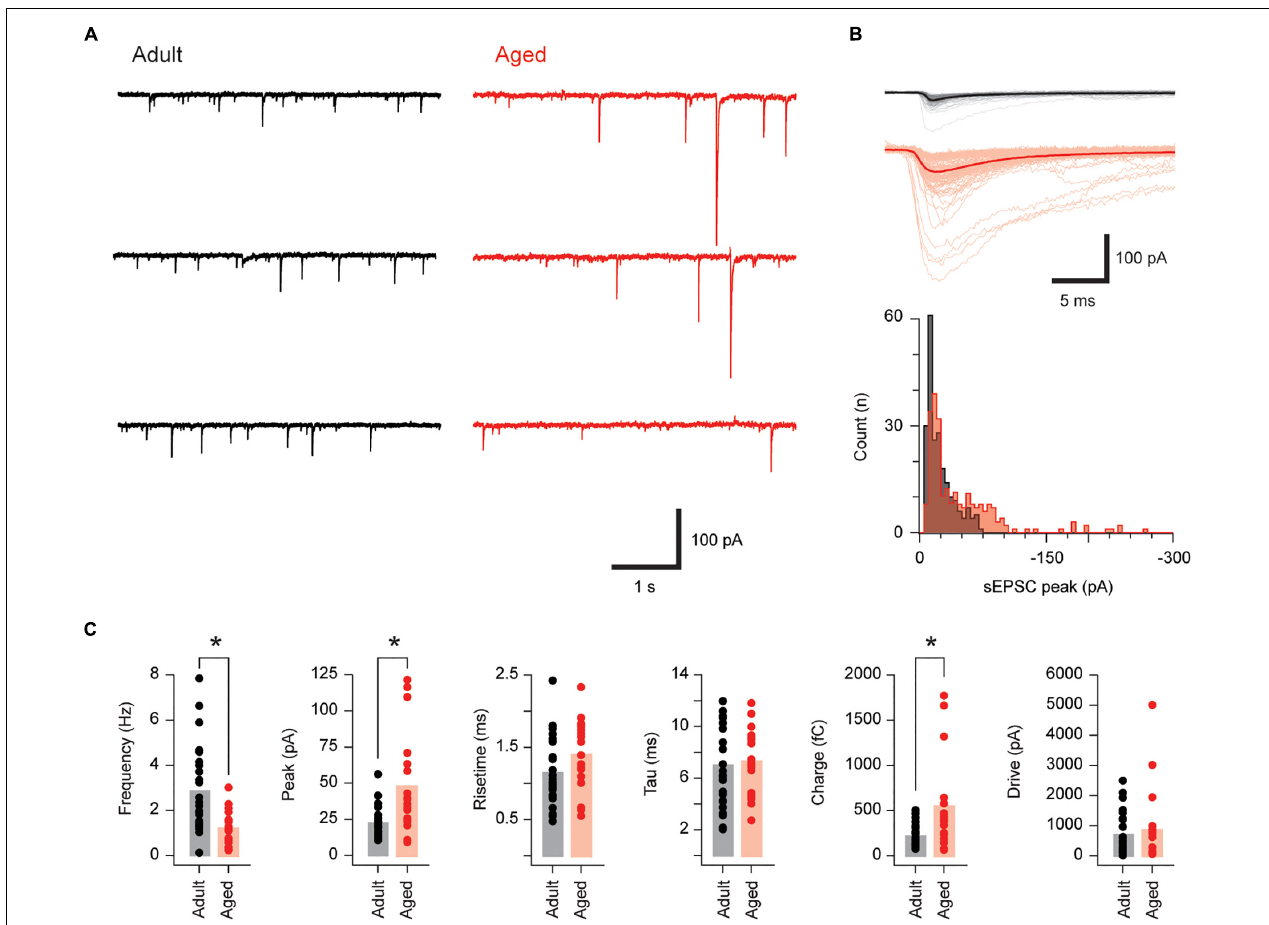
FIGURE 2 | Excitatory synaptic drive is unchanged in aged PVINs. (A) Traces show continuous sEPSC recordings from adult and aged PVINs. Note, sEPSC amplitude is clearly greater in aged PVINs. (B) Upper overlaid sEPSC traces are captured from the data in (A) . The average of these captured events (heavy trace) emphasizes the increased sEPSC amplitude in aged animals. Lower plots show amplitude histograms highlighting a population of right shifted larger sEPSCs in the aged recording. (C) Plots comparing group data for sEPSC properties in PVINs from adult and aged mice. In aged mice, sEPSC amplitude and charge are increased whereas sEPSC frequency is reduced. sEPSC time course (rise and decay time) and synaptic drive (charge per second) are unchanged in aged PVINs (asterisks indicate significant differences, p < 0.05). Each data point represents the mean of at least 20